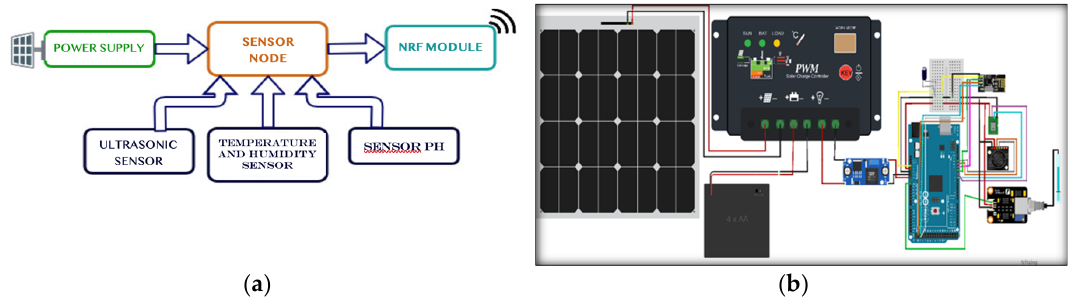
Figure 2. Structure of the Sensor Node (NS): ( a ) NS block diagram. ( b ) NS connection diagram.